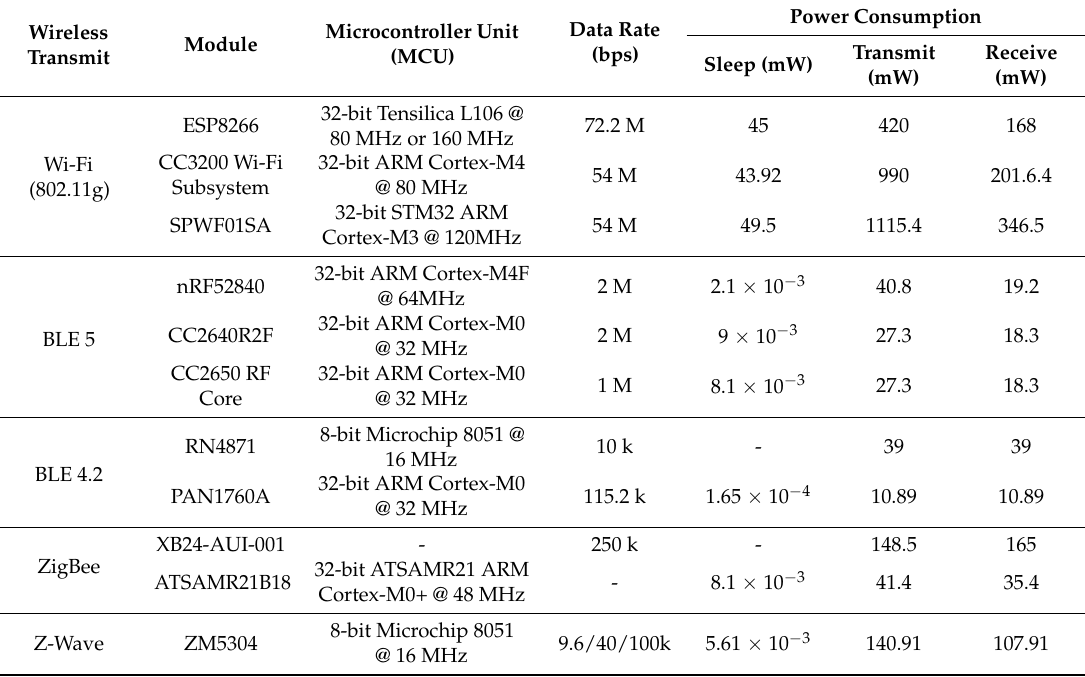
Table 2. Typical wireless communication modules and parameters.